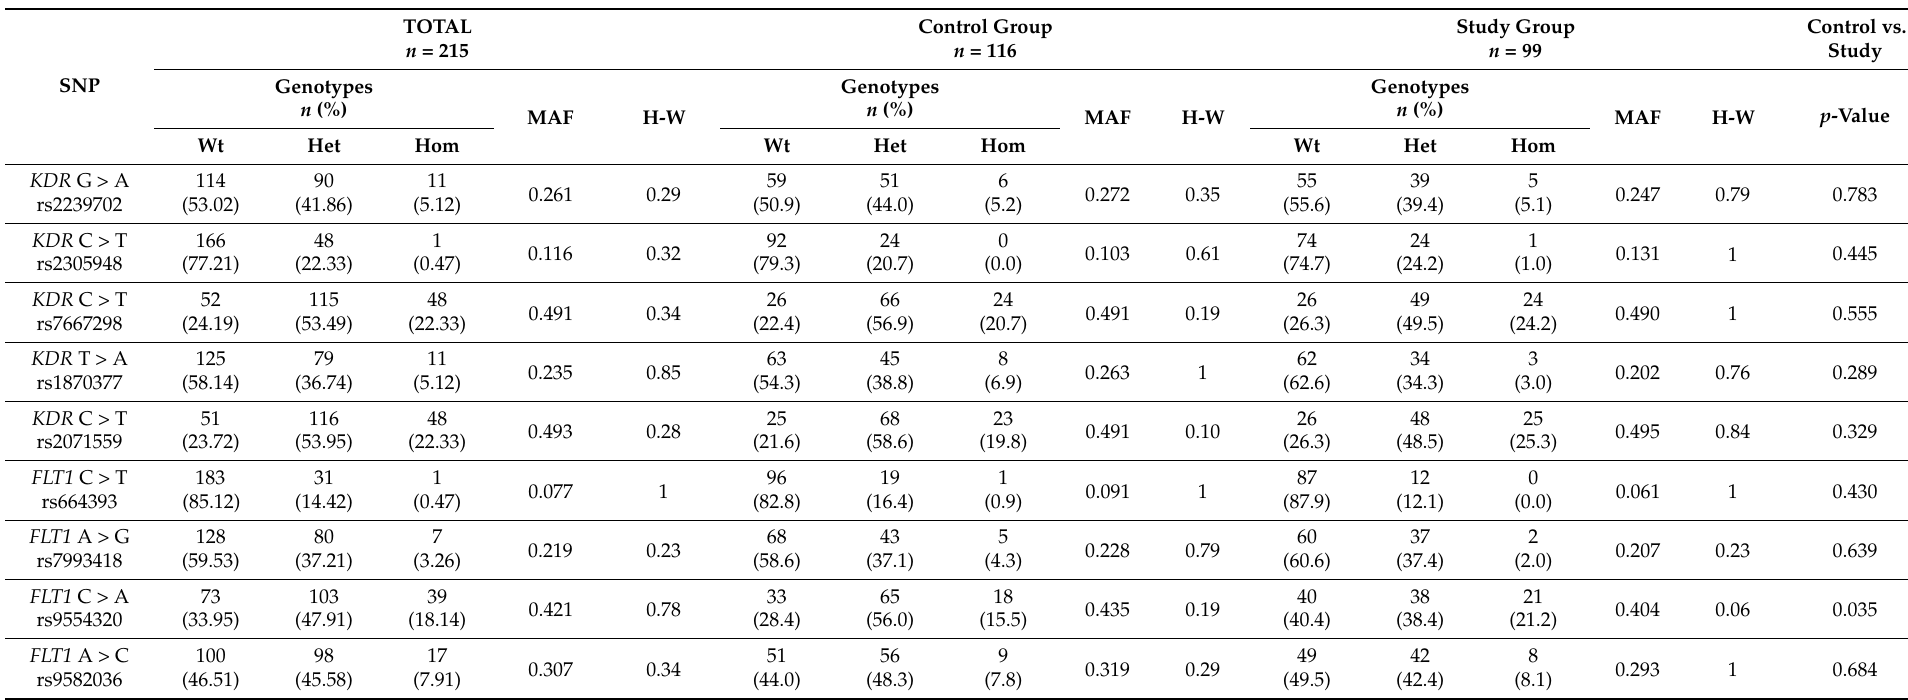
Table 2. Genotype distribution, minor allele frequency, and Hardy–Weinberg equilibrium analysis for each studied SNP in our